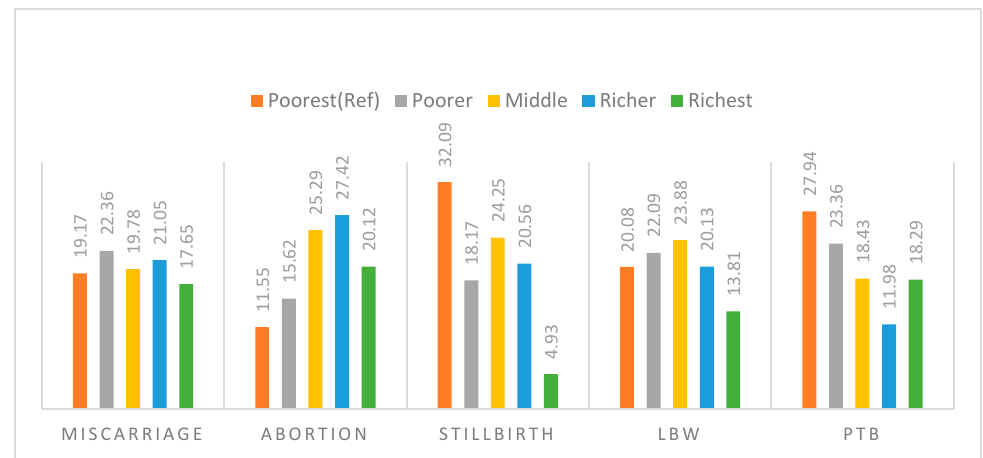
Figure 5. Percentage of women in each adverse birth outcome category by household wealth quintile. Source: Authors’ calculations.